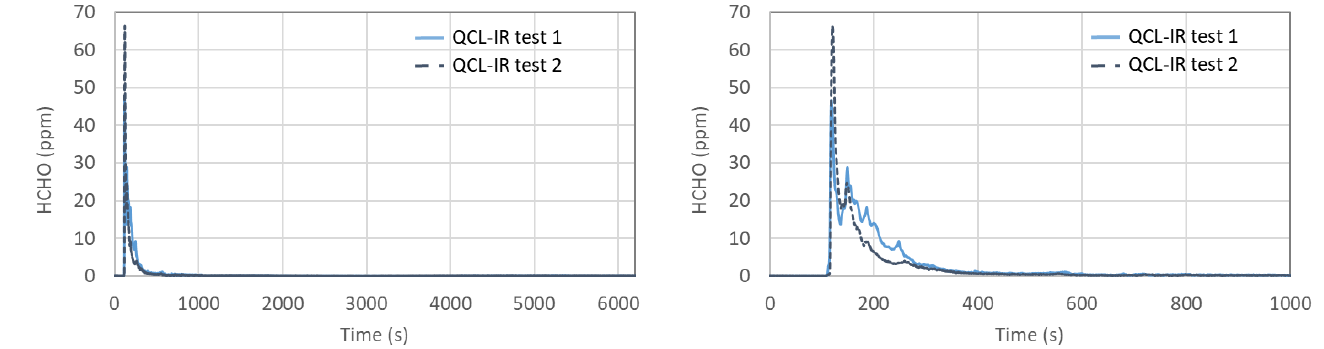
Figure 5. Real-time HCHO emission concentrations measured using the QCL-IR from the DV during two on-road tests. Right panel illustrates a close-up of the first 1000 s of the same tests and was introduced for visualization purposes.